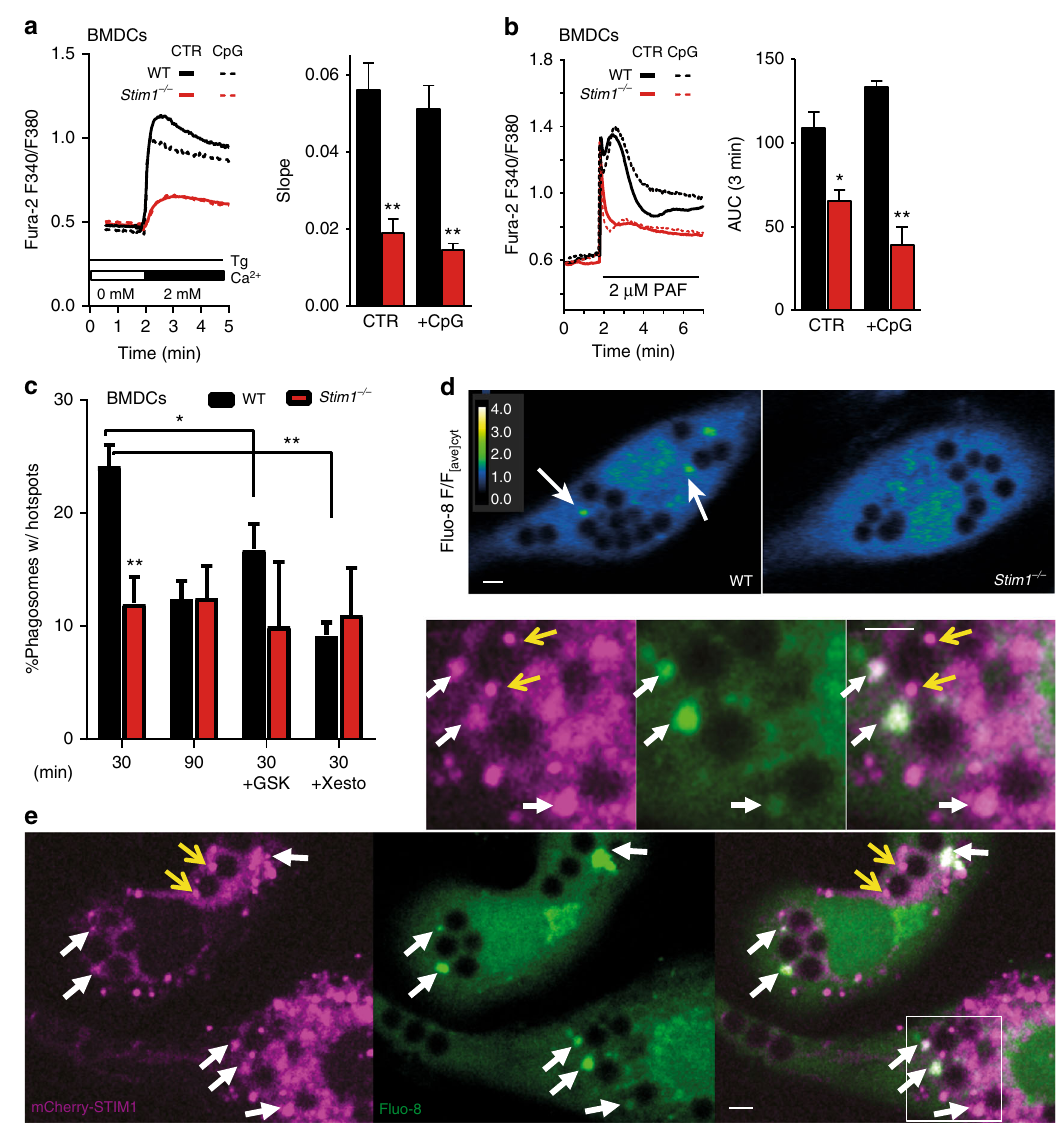
Fig. 3 STIM1 localizes near phagosomes and promotes global and local Ca 2+ signals in BMDCs. a , b Stim1 ablation strongly decreased SOCE in immature and CpG-matured BMDCs, measured as the slope of Ca 2+ -re-entry after store depletion with 1 μ M Tg in Ca 2+ -free medium and 2 mM Ca 2+ re-addition a , or as the area under the curve (AUC) of the fi rst 3 min after acute exposure to the agonist PAF (2 μ M, b ). Traces are averages of 11 – 23 cells. N = 10/6; 3/4 (coverslips each) containing 129/119; 26/70 (WT) or 139/98; 67/97 ( Stim1 − / − ) cells for Tg: CTR/CpG; PAF: CTR/CpG. c , d Localized Ca 2+ signalling near phagosomes (green dots, arrows, d ) was measured in BMDCs loaded with 4 μ M Fluo-8 and 2.5 μ M BAPTA after 30 min or 90 min of exposure to targets, and in the absence or presence of 10 μ M GSK or 1 μ M Xesto after 30 min ( c ). Stim1 ablation reduced periphagosomal Ca 2+ hotspots at 30 but not 90 min, and both GSK and Xesto reduced hotspot frequency in WT but not Stim1 − / − cells ( c ). N = 5/4;7/4;5/3;6/4 coverslips representing 870/794; 1916/1154; 898/814; 1124/1372 phagosomes; 196/178; 370/238; 270/265; 375/211 cells for WT/ Stim1 − / − 30;90:30+GSK;30+Xesto. The colour-coded ratio images are Fluo-8 fl uorescence/average cytosolic Fluo-8 fl uorescence and show representative hotspots ( d ). e BMDCs transduced with mCherry-STIM1 (magenta) and loaded with Fluo-8 (green) as above display periphagosomal accumulations of STIM1 fl uorescence that co-localize with Ca 2+ hotspots (white arrows), as well as puncta that show no Ca 2+ activity (yellow arrows). 20:1 target:cell ratio. Bars = 3 μ m. Error bars are means+ SEM, * p < 0.5, ** p < 0.1 using a Student ’ s t